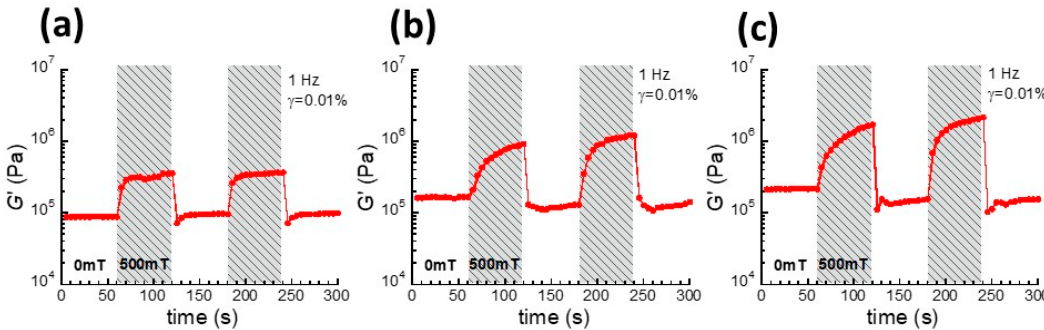
Figure 2. Magnetic field responses of the storage modulus under the linear viscoelastic regime for magnetic elastomers containing ( a ) SP, ( b ) LP, and ( c ) LP+NP.